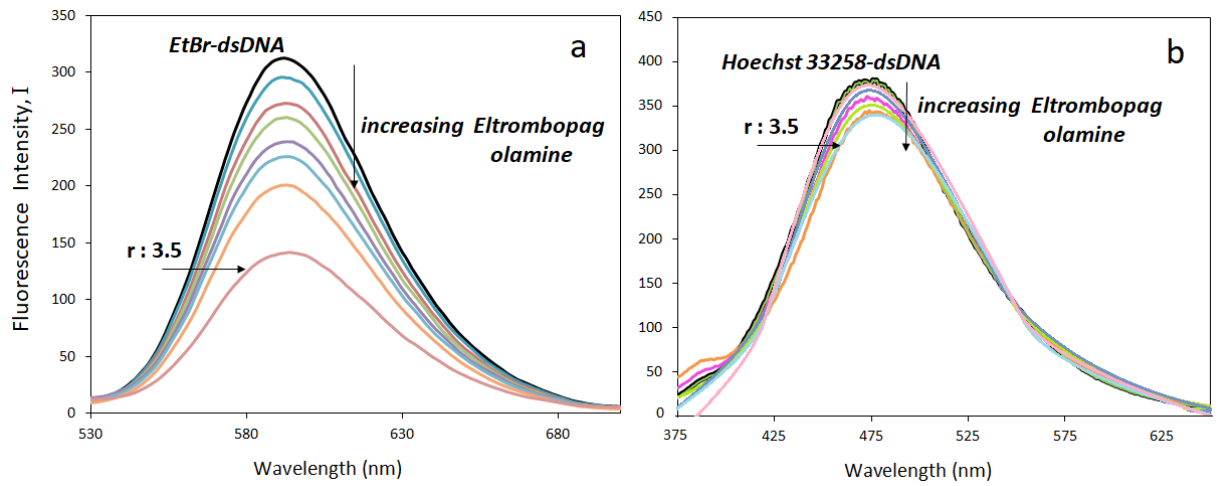
Figure 8. Fluorescence titration of ( a ) EtBr–dsDNA, ( b ) Hoechst-33258–dsDNA mixtures with ELT (r = [ELT]/[dsDNA]).